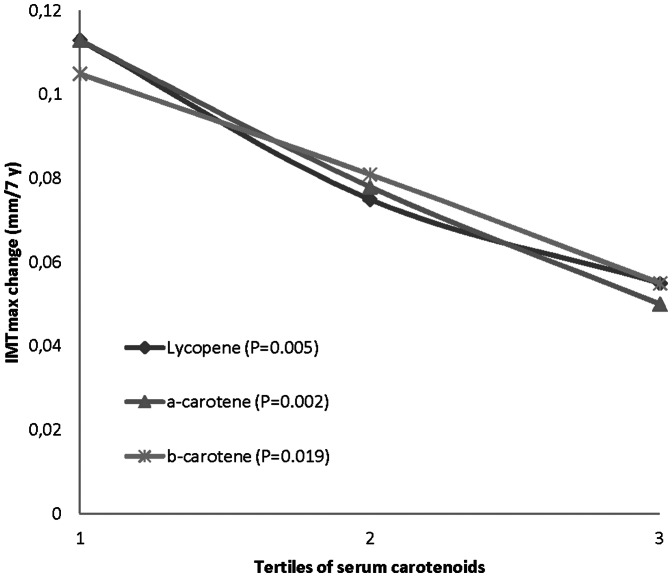
Serum carotenoid tertiles by 7-year IMTmax change (adjusted for age, examination year, ultrasound sonographer, BMI, SBP, IMTmax, smoking, serum LDL cholesterol, physical activity, CHD in family, antihypertensive medication and serum hs-CRP.Probability values are for trend. Carotenoid tertiles (µmol/L): lycopene: ≤0.09, 0.10–0.19, ≥0.20; α-carotene: ≤0.07, 0.08–0.11, ≥0.12; β-carotene: ≤0.26, 0.27–0.41, ≥0.42.